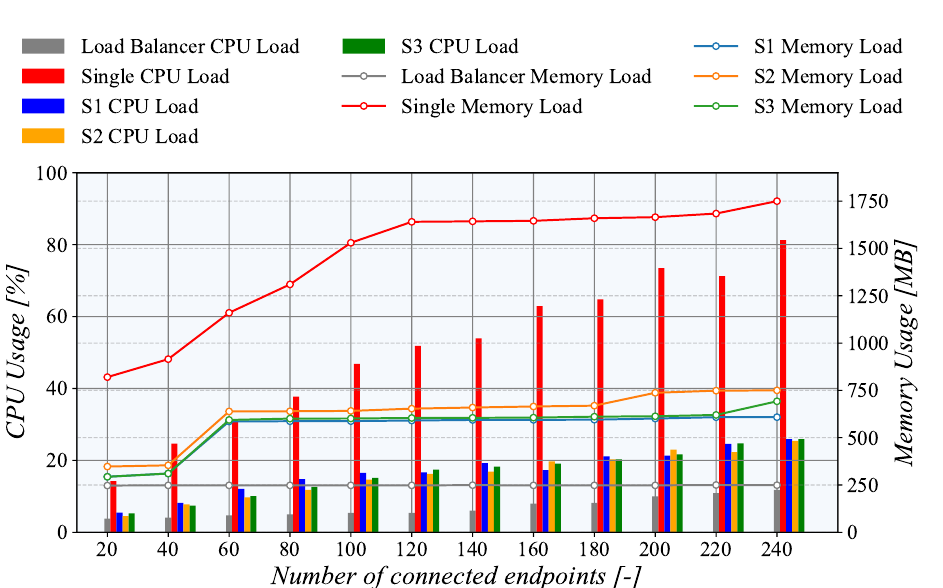
Figure 16. Utilization of system resources on the collector side during load balancing